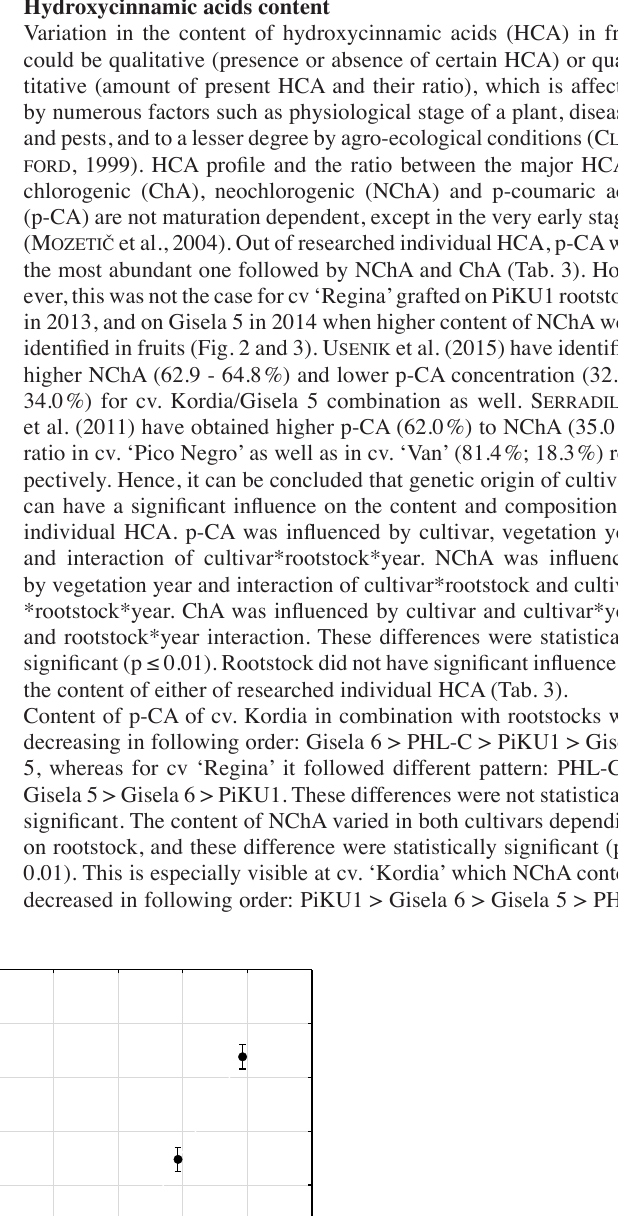
rootstock: 5Gisela 6 Gisela